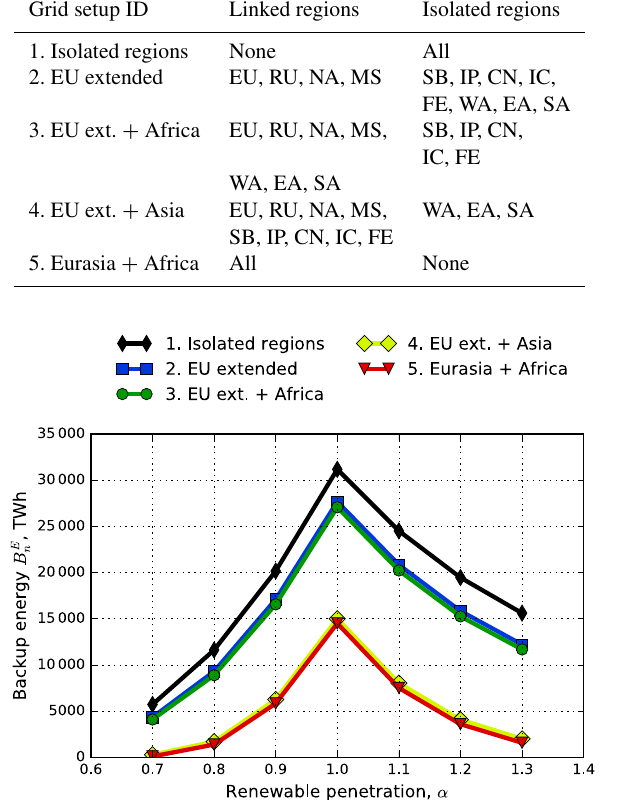
Figure 5. Yearly backup energy need and its deviation from 10-year average (cid:49)B C n = (cid:104) B C n (cid:105)− B C n for Afro-Eurasian grid with α = 1. pate in power exchange, excess renewable power is used to balance the demand throughout the grid.